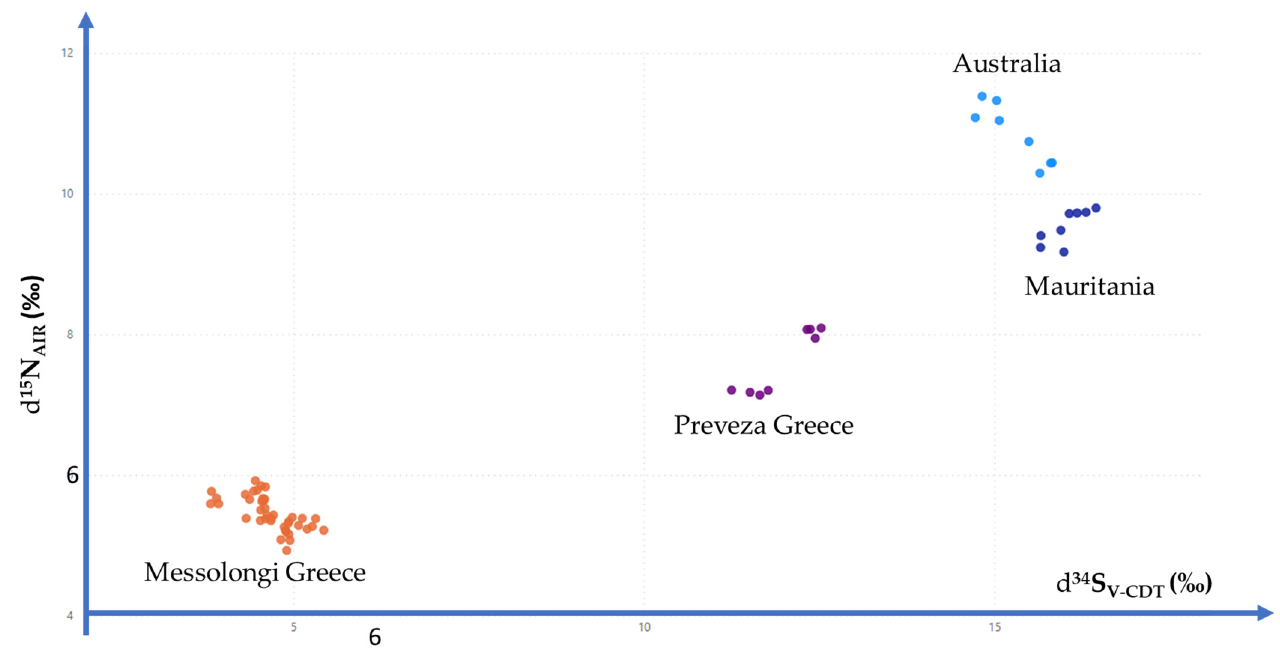
Figure 4. Results for Bottarga δ 15 N AIR (‰) and δ 34 S V-CDT (‰) in a 2-dimension scatterplot.